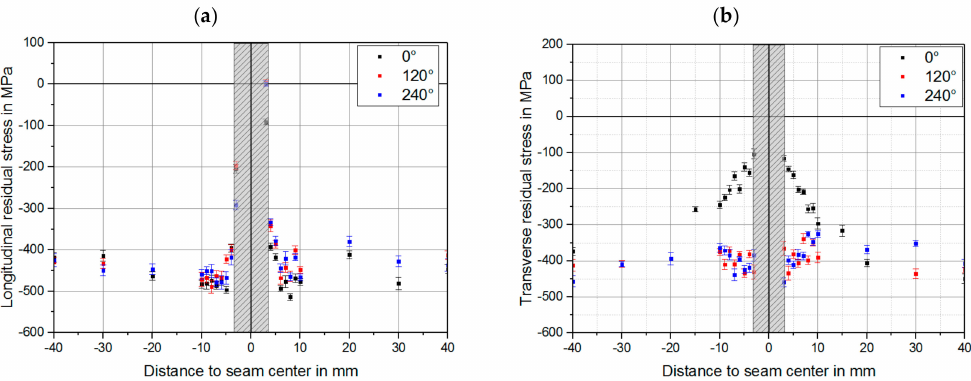
Figure 7. Comparison between residual stress values for the welded sample, IN625_WOHT_CT, in three segments in the weld circumference for ( a ) longitudinal direction and ( b ) transversal direction to the weld